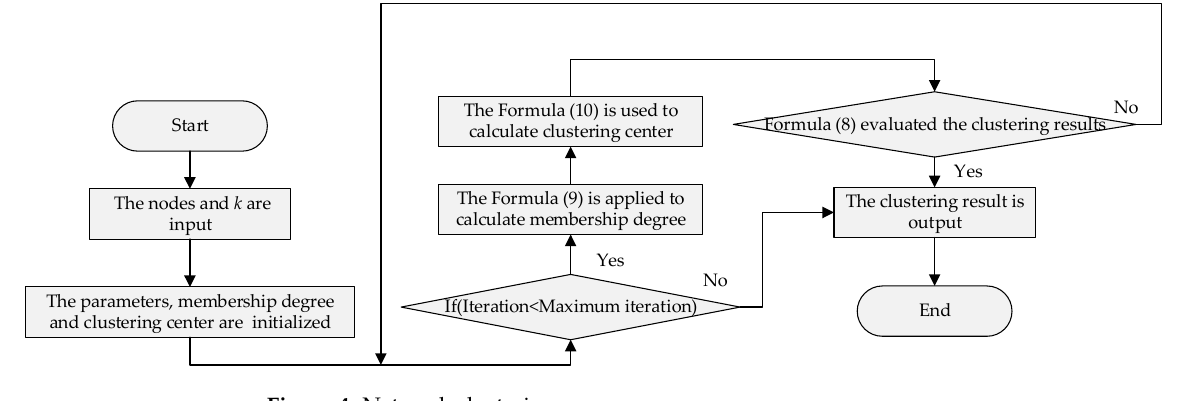
Figure 4. Network clustering.